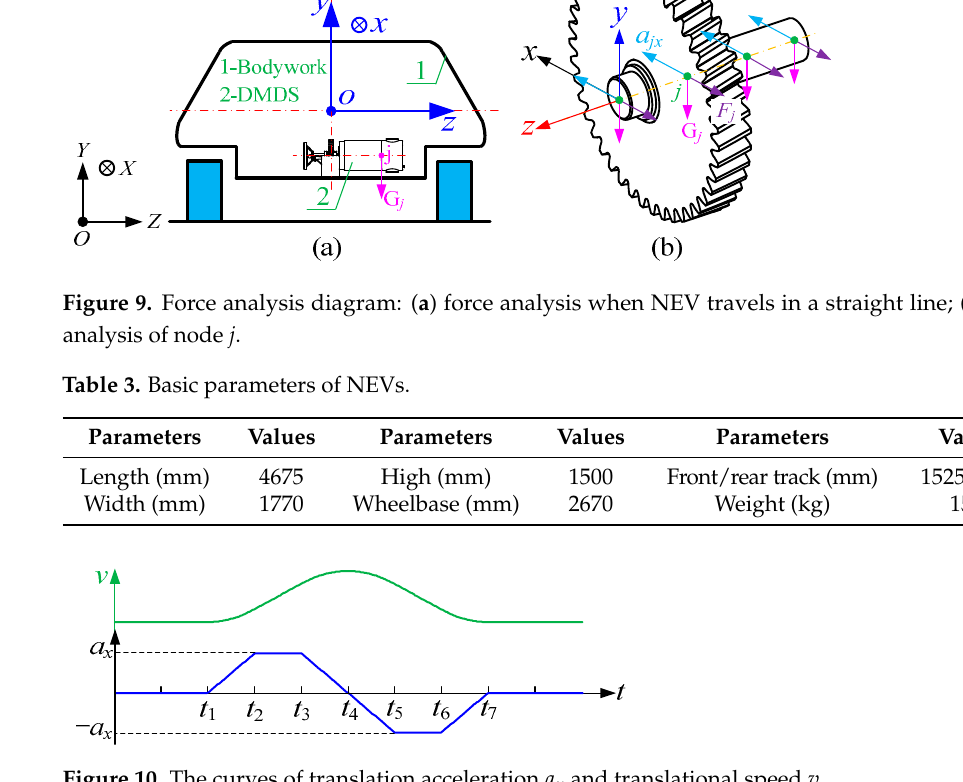
Figure 9. Force analysis diagram: ( a ) force analysis when NEV travels in a straight line; ( b ) force analysis of node j.